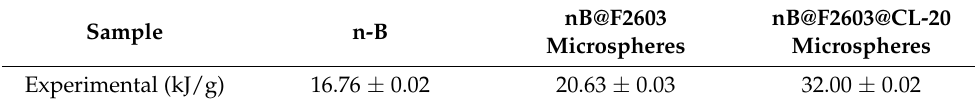
Table 2. Combustion heat value of n-B and nB@F2603 and nB@F2603@CL-20 microspheres. Sample